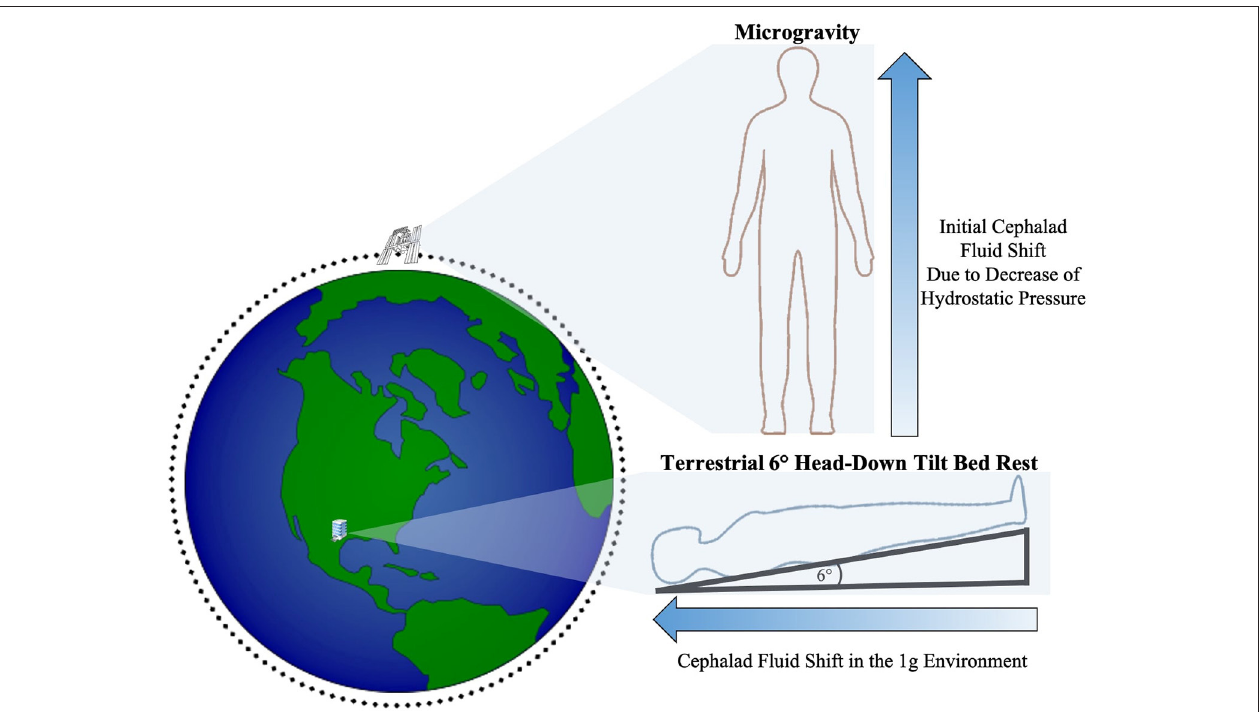
FIGURE 1 | Illustration of the initial cephalad fluid shift in the microgravity environment due to loss of hydrostatic pressure and cephalad fluid shift during terrestrial HDTBR studies (not drawn to